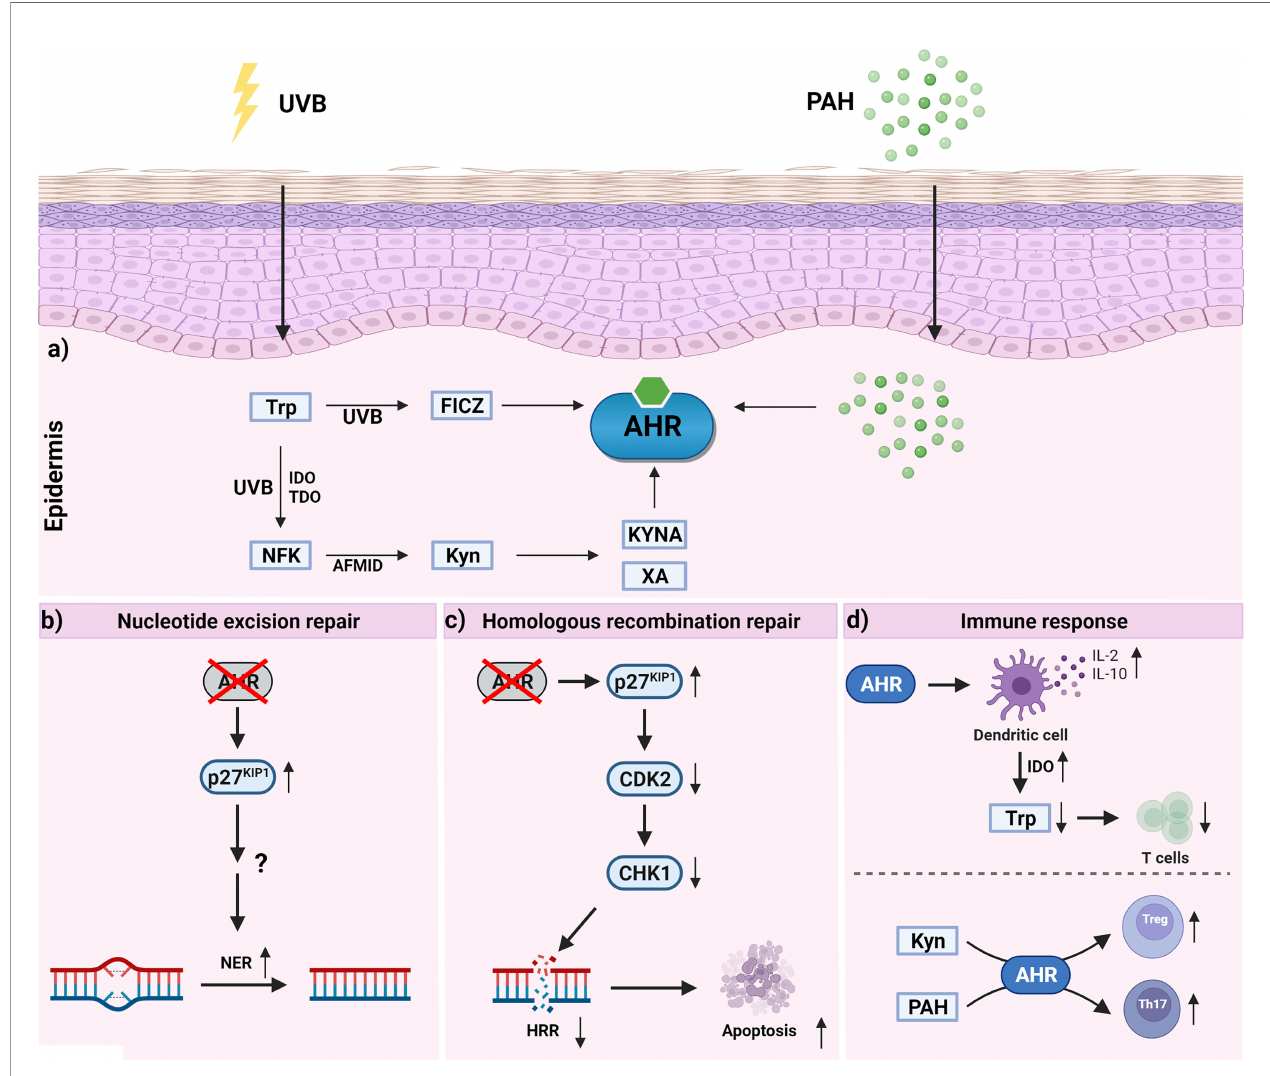
FIGURE 3 | Activation of epidermal AHR signaling and AHR-dependent effects which may contribute to skin carcinogenesis. a) UVB irradiation of epidermal cells results in the formation of tryptophan photoproducts, such as FICZ and NFK. While FICZ is a high-af fi nity ligand for AHR, NFK is considered as a pro-ligand. Speci fi cally, aryl formamidase converts NFK to kynurenine (kyn) which in subsequent metabolic reactions is metabolized to the AHR agonists kynurenic acid (KYNA) and xanthurenic acid (XA). b) Inhibition of AHR was shown to increase p27 KIP1 protein content which improves NER of UVB radiation-induced DNA photoproducts by a yet enigmatic mechanism. c) Inhibition of AHR was shown to increase p27 KIP1 protein content resulting in an inhibition of CDK2 and a time-dependent decline of the CHK1 level. The reduction of CHK1 is associated with a reduced performance of the HRR system and an elevated rate of keratinocyte apoptosis. d) AHR activation affects T cell polarization in a ligand-dependent manner. The upregulation of IL-2, IL-10 and IDO in DC may lead to an expansion of Tregs and inhibit the proliferation of effector T cells via tryptophan depletion. In contrast to the pro-ligand KYN, PAHs seem to interfere with differentiation and function of immunosuppressive